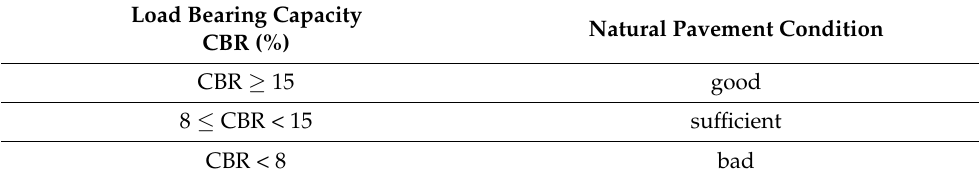
Table 3. Assessment criteria of the load bearing capacity for the natural AFE at a depth of 0.15 m up to 0.50 m (layer 2).